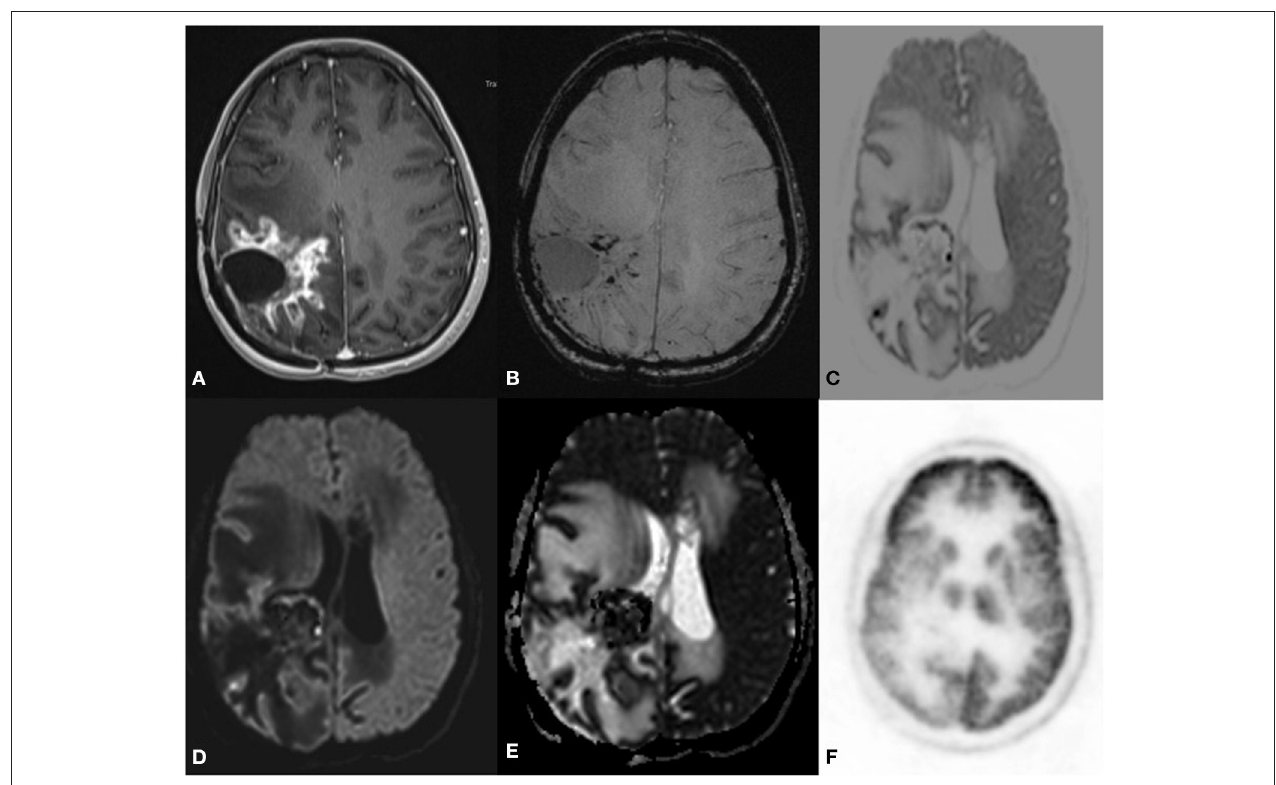
FIGURE 9 | A 34 year old female postoperative case of anaplastic clear cell Ependymoma, 7 year follow up MRI F-18 choline PET axial images SWI (B) postcontrast T1 (A) Inverted DWI (C) DWI b2000 (D) ADC (E) NAC PET (F) showed a Swiss cheese and nodular enhancement lesion in the right parietal region. The lesion shows DWI restriction with hypermetabolism on PET. There is a match on the inverted DWI image and the NAC PET image, which is suggestive of